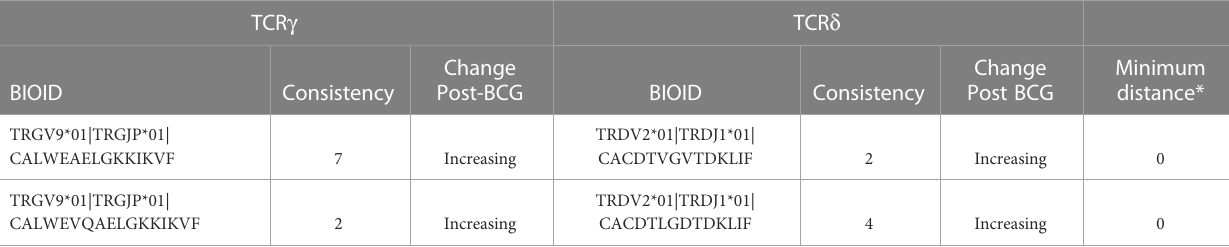
TABLE 2 Paired TCR g and TCR d single-chains observed in single-cell, paired-chain data.